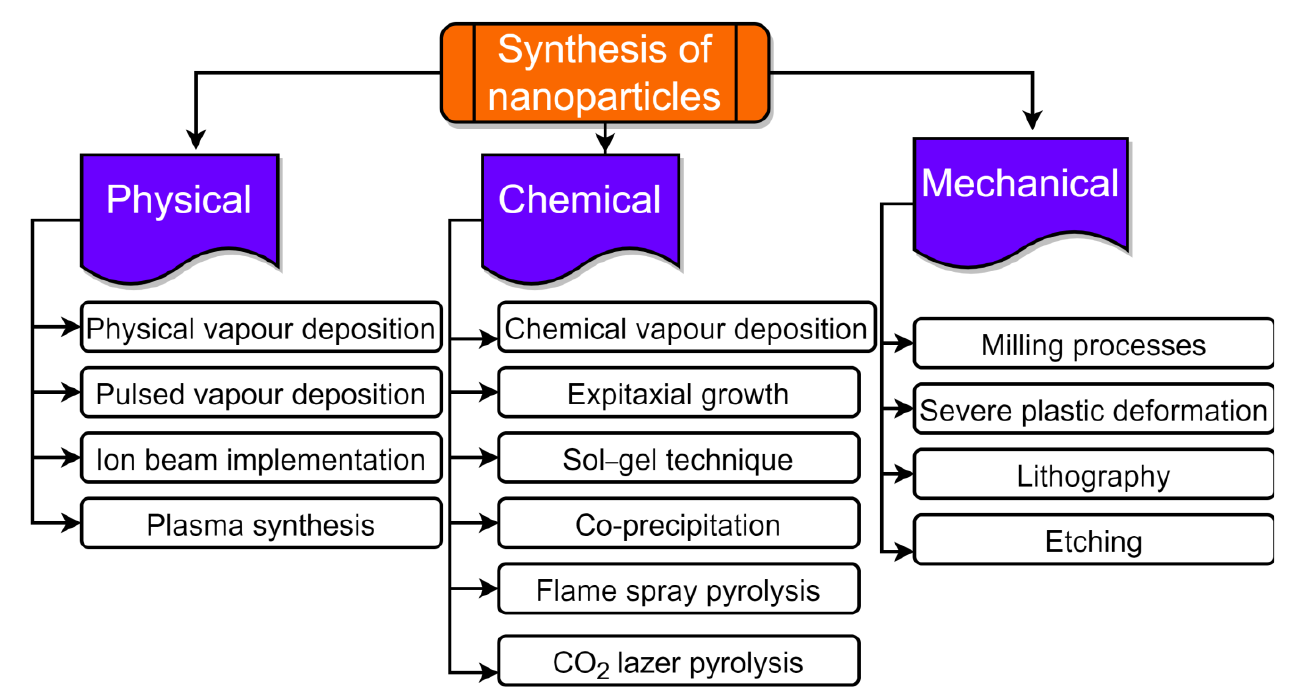
Figure 2. Synthesis of nanoparticles from agro-waste.